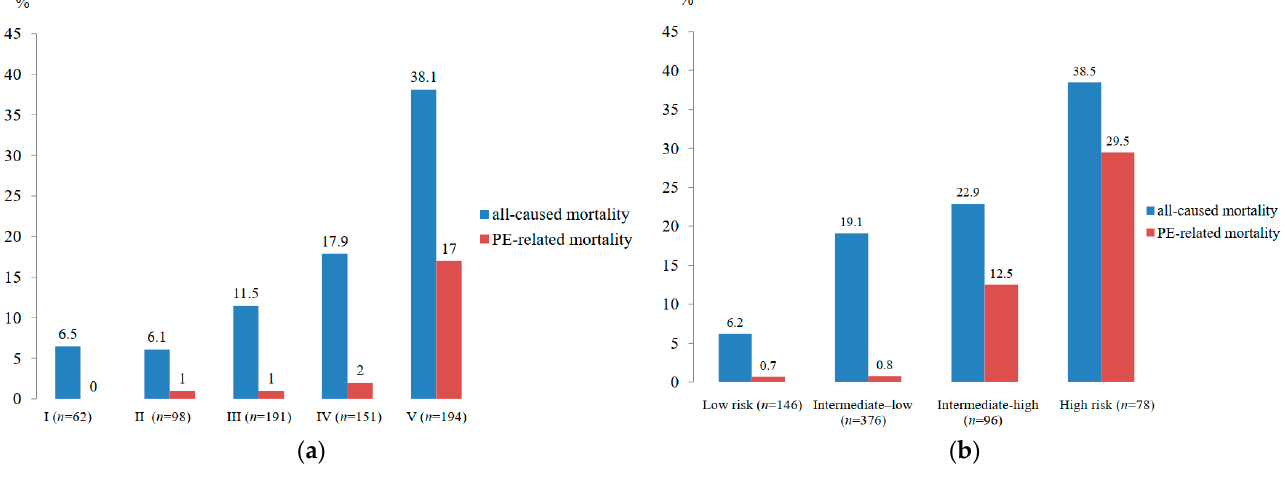
Figure 2. Thirty-day All-cause Mortality and PE-related Mortality According to PESI Classification and ESC 2019 Risk Stratification. Note: ( a ), 30-day all-cause mortality and PE-related mortality ac- cording to PESI classification; ( b ), 30-day all-cause mortality and PE-related mortality according to ESC 2019 risk stratification.